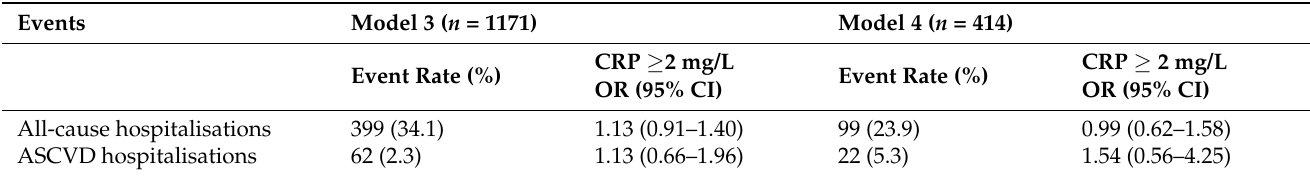
Table A11. Association of elevated CRP levels ( ≥ 2 mg/L) with different hospitalisation events at 12 months with adjustment for BMI and lipid parameters in a